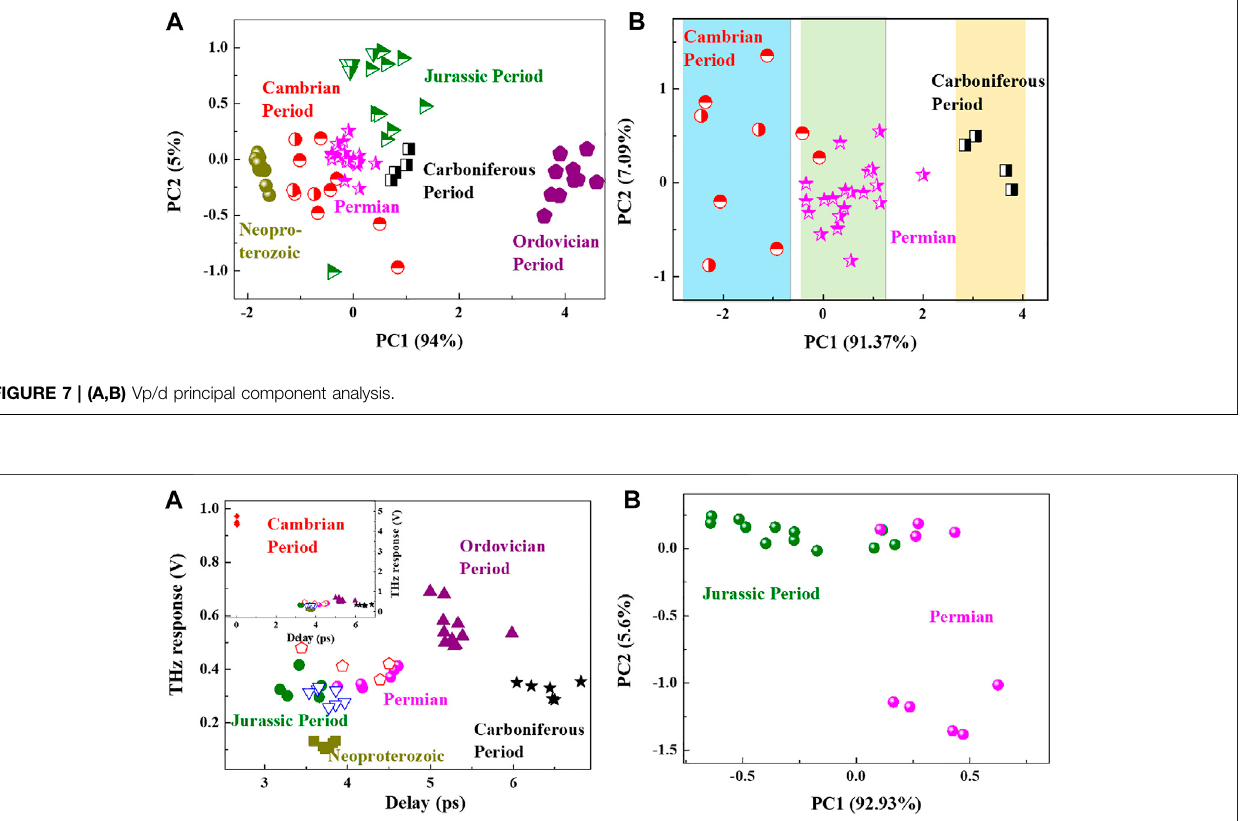
FIGURE 8 | (A), (B) Vp/d principal component